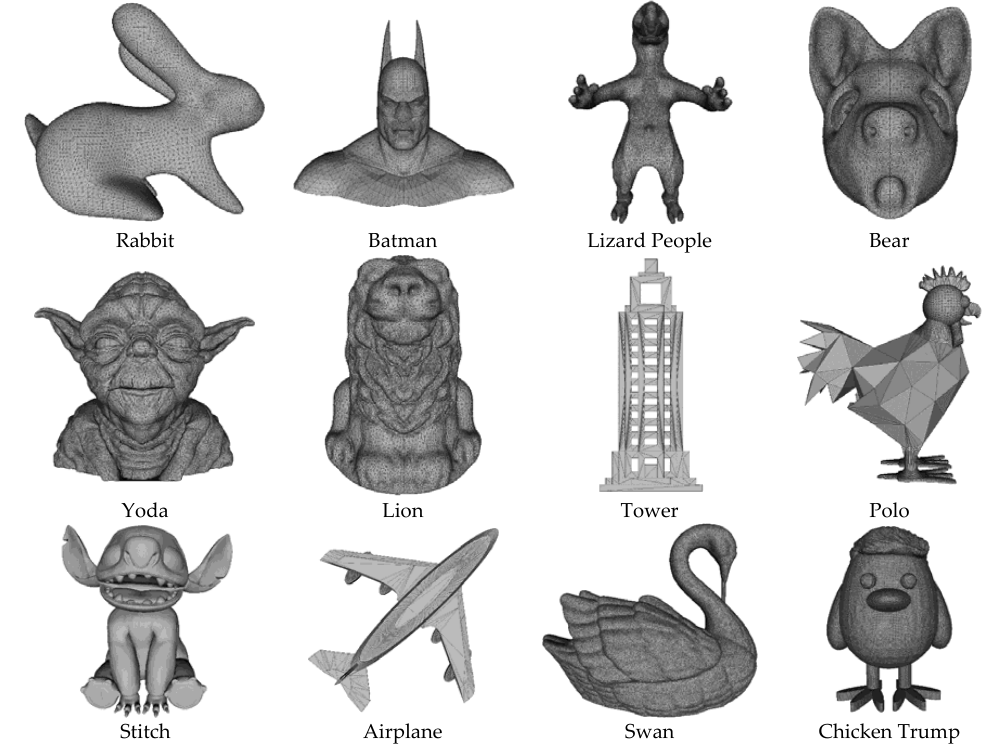
Figure 6. Test Models.